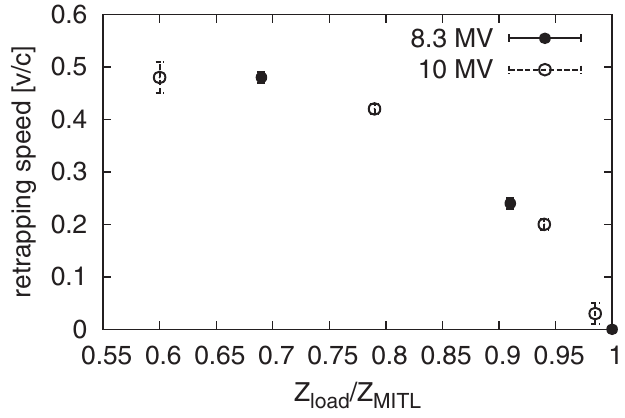
FIG. 8. Speed of the retrapping wave as a function of load impedance normalized to the line-limited impedance for the straight MITL. Uncertainties are ascribed based on the accuracy with which retrapping times can be determined in simulation.